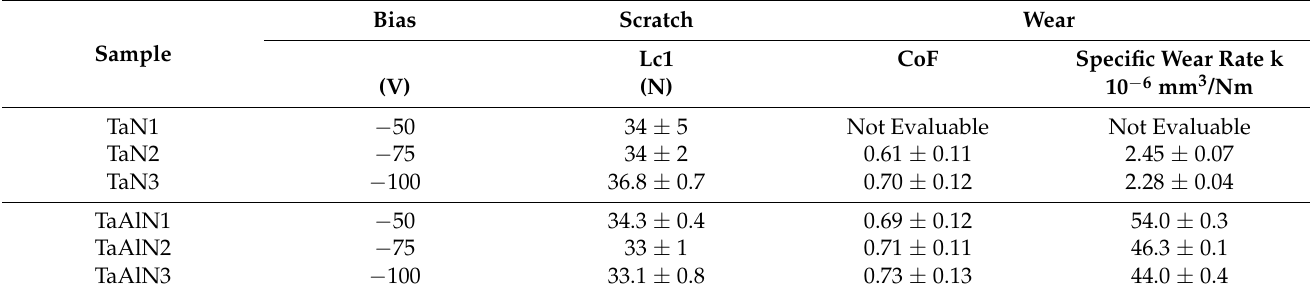
Table 3. Critical loads in scratch tests and tribological data after wear tests of Ta-N and Ta-Al-N coatings.